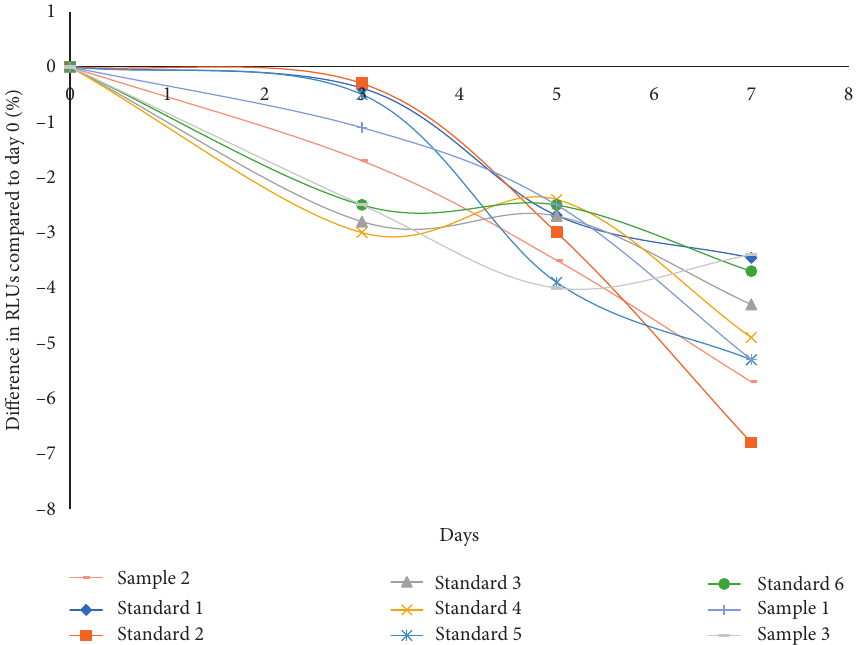
Figure 4: Accelerated stability results of reagent kits at 37 °